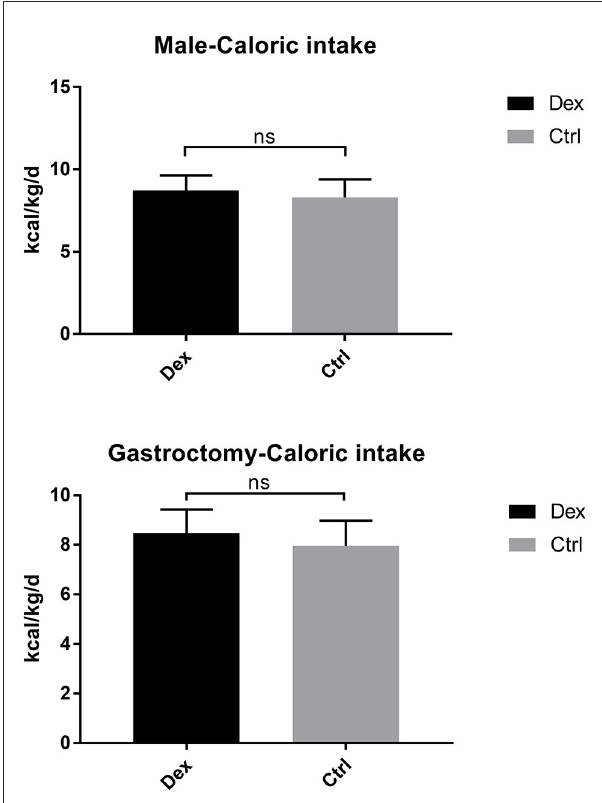
FIGURE2 Avervage daily enteral nutrition caloric intake in the male and gastrosurgery groups. ns P >